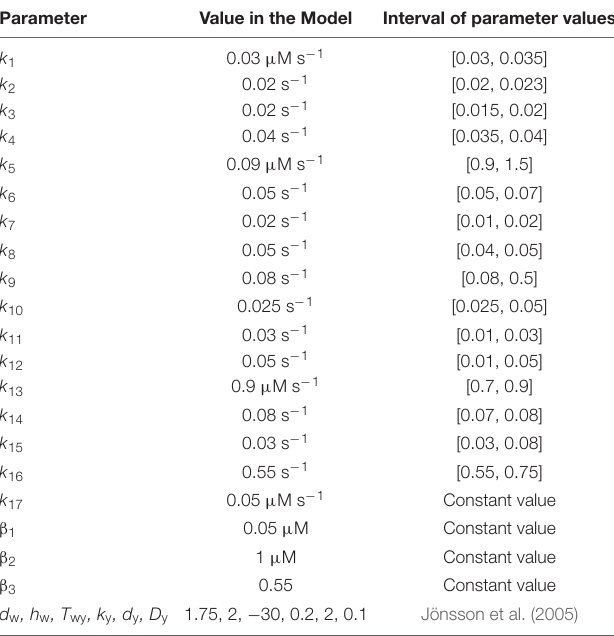
TABLE 1 | Parameter values for the spatial ABC patterning model of flowering. Parameter Value in the Model Interval of parameter values